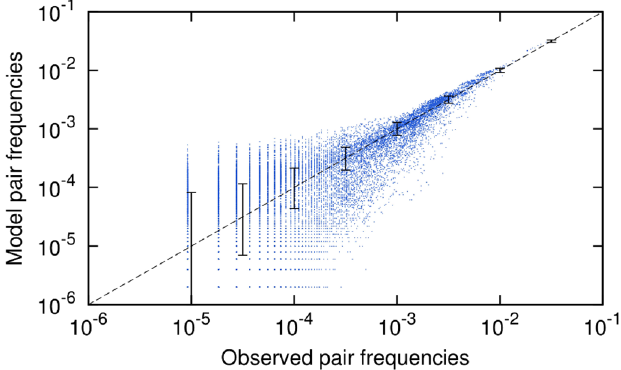
Figure 2. Model VS Corpus pair frequencies. The Corpus ones are from the corpus Weimar Jazz Database (that contains detailed transcriptions of famous jazz improvisations. As of march 2015 the database contains 257 songs) 12 (see Section S3 in the SI for additional information). The model frequencies come from a N = 200000 sequence generated by a K max = 10 model trained on the above corpus. Since the corpus is finite we added 99% confidence intervals for the estimated corpus frequencies. Their values were computed using the Wilson Score interval which is well adapted for values very close to